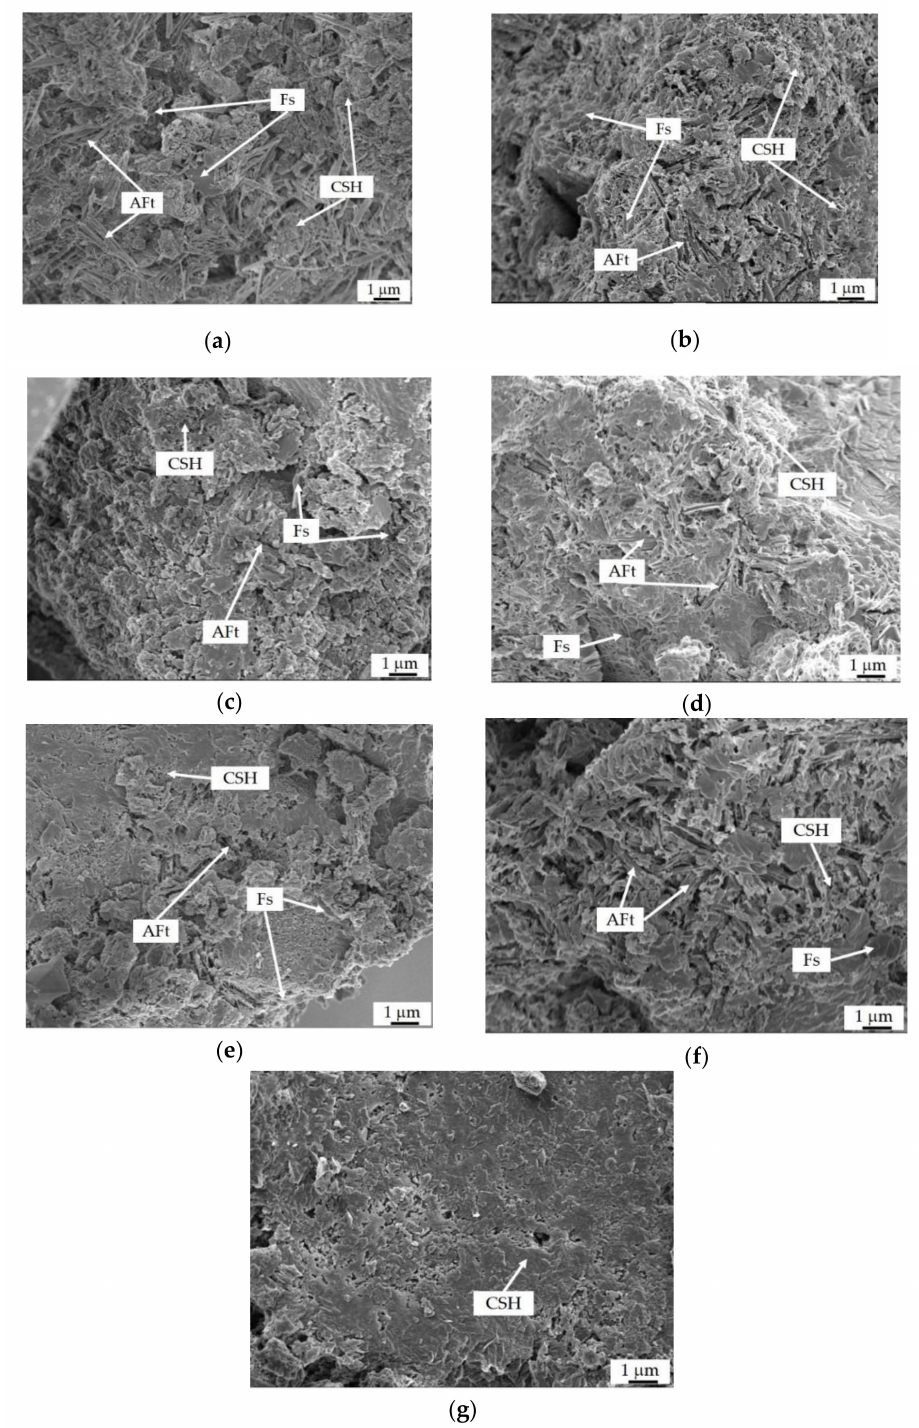
Figure 6. SEM images of mortars at 28 d: ( a ) C0; ( b ) C1; ( c ) C2; ( d ) C3; ( e ) CS1; ( f ) CC2; ( g )